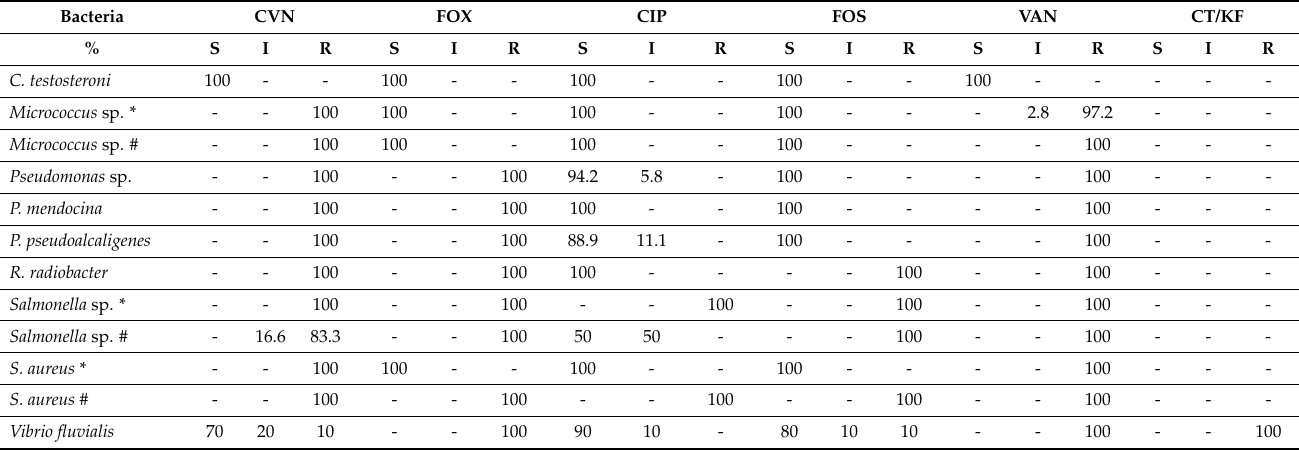
Table 4. Percentage of antimicrobials susceptible (S), intermediate (I) or resistant (R). From *Sp. A and from #Sp. B. CVN (Cefovecin), FOX (Cefoxitin), CIP (Ciprofloxacin), FOS